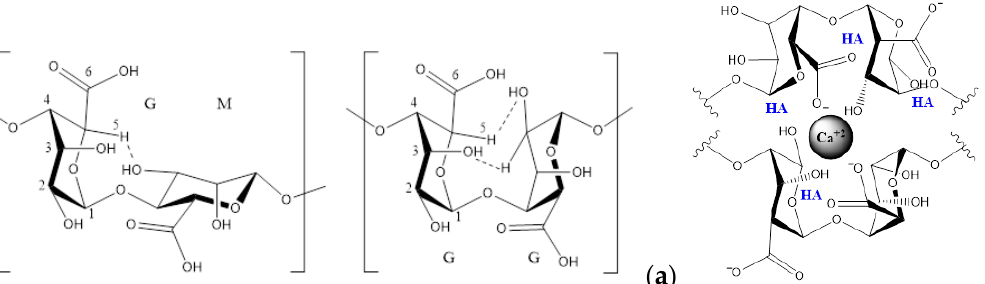
Figure 1. ( a ) Conformation possible of GM and GG diads due to the hydrogen-bonds. ( b ) Schematic representation of alginate-hydroxyapatite-Ca +2 .